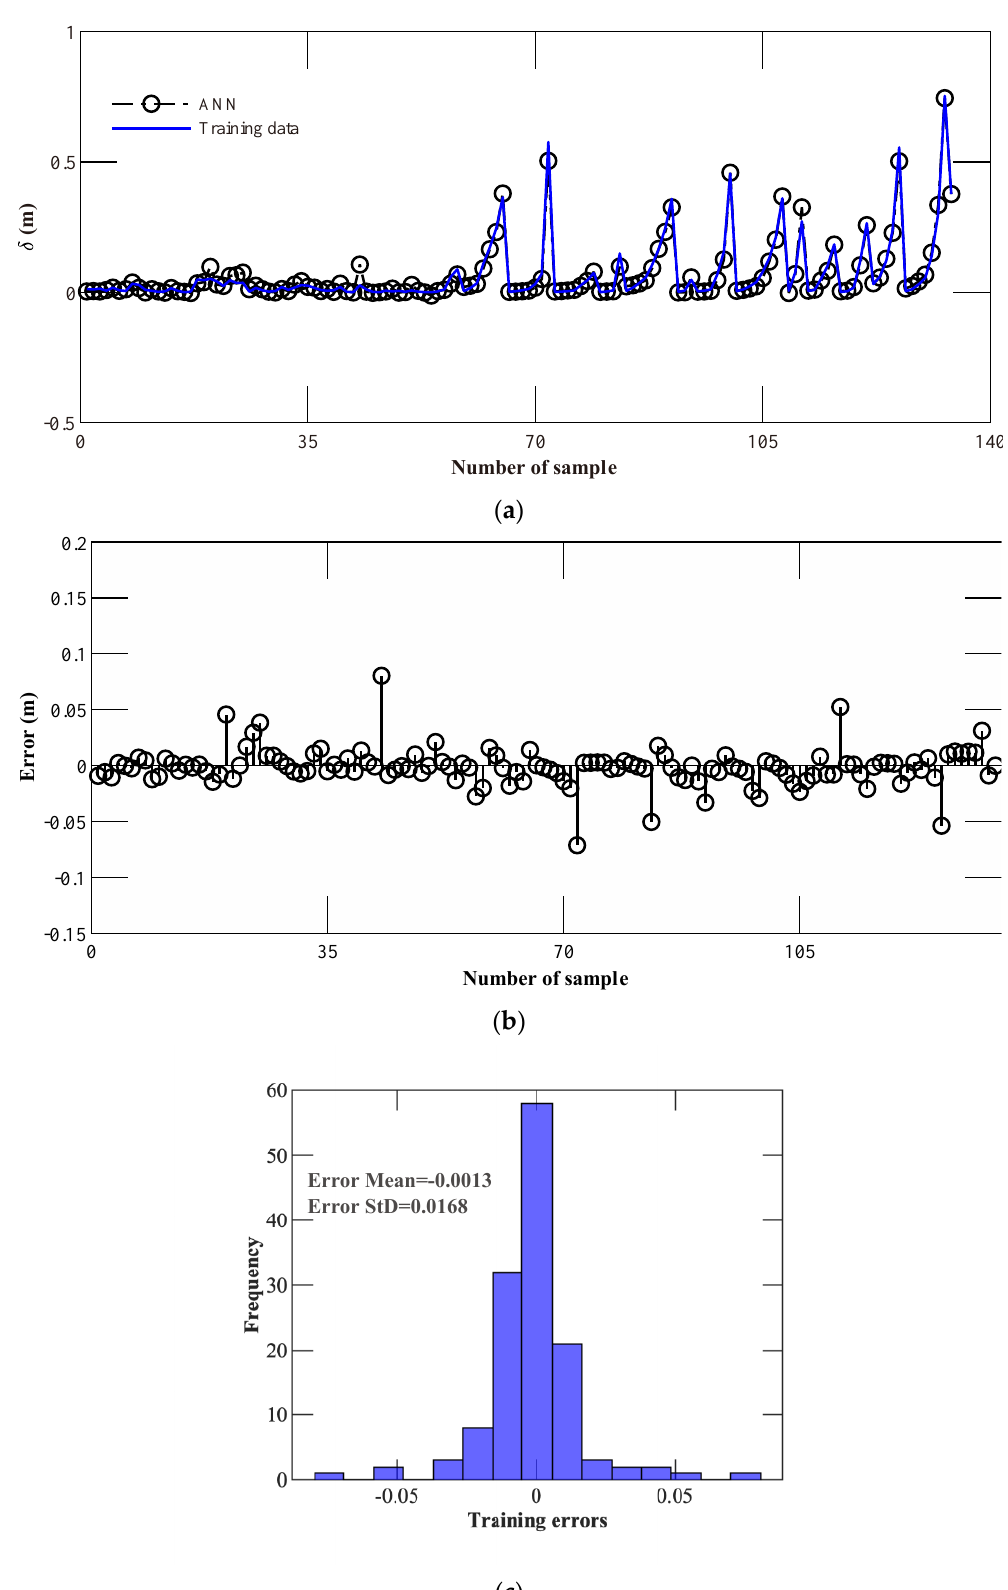
Figure 9. The performance of training data: ( a ) Predicted versus actual data; ( b ) error; ( c ) the histogram of error values.